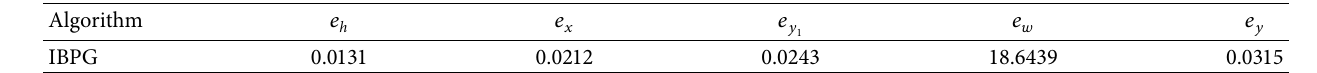
Table 3: Estimation errors for the OEAHW model using IBPG